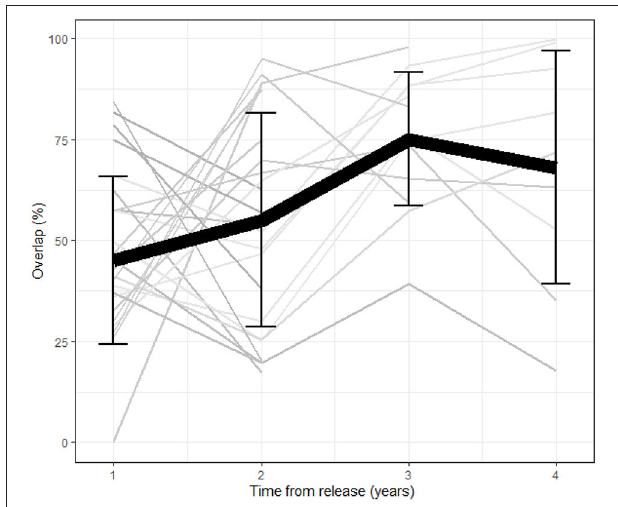
FIGURE 1 | Average overlap between consecutive year home ranges as a function of time from release (in years) per individual ( n = 34). The black line represents the population mean and error bars represent the standard deviation per year. The overall overlap increases as a function of time from release reflecting a stabilization